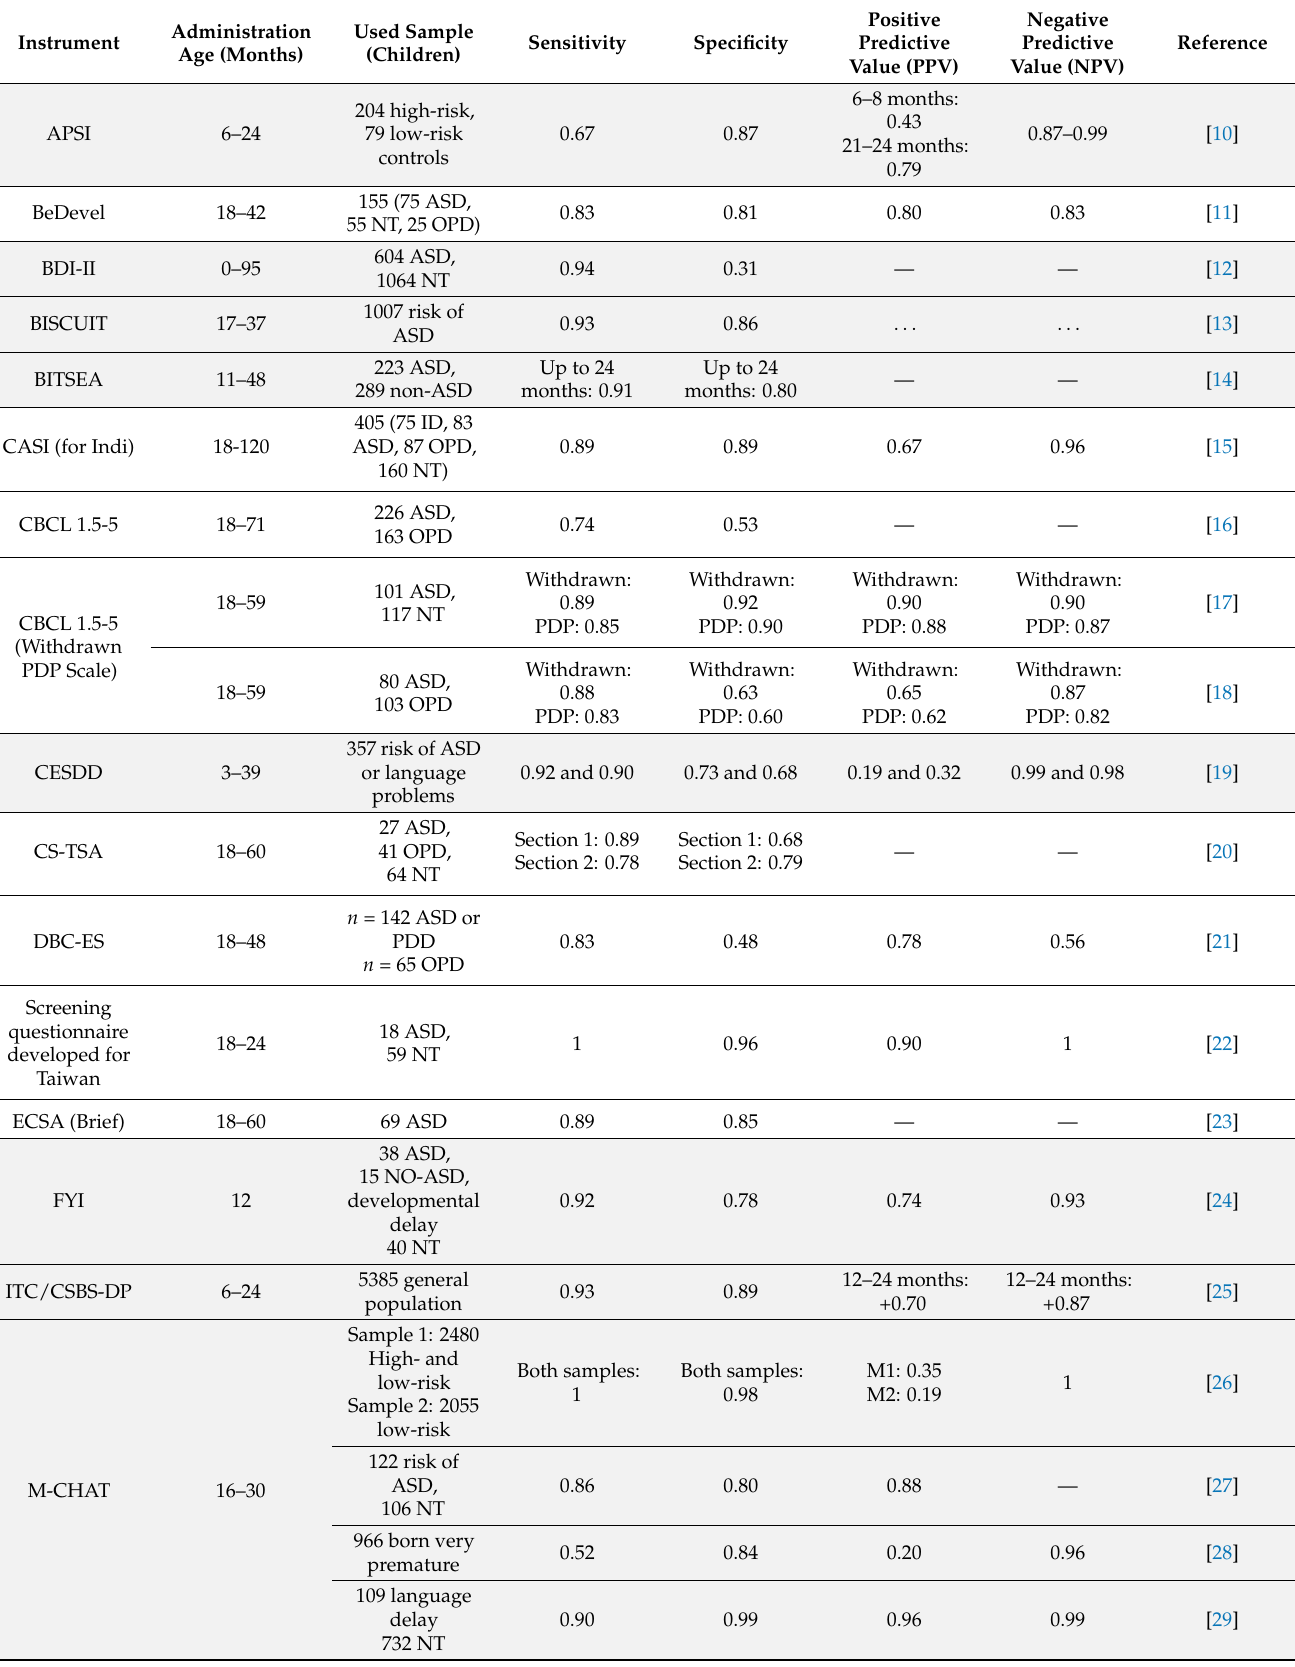
Table 1. Screening instruments for a population under two years of